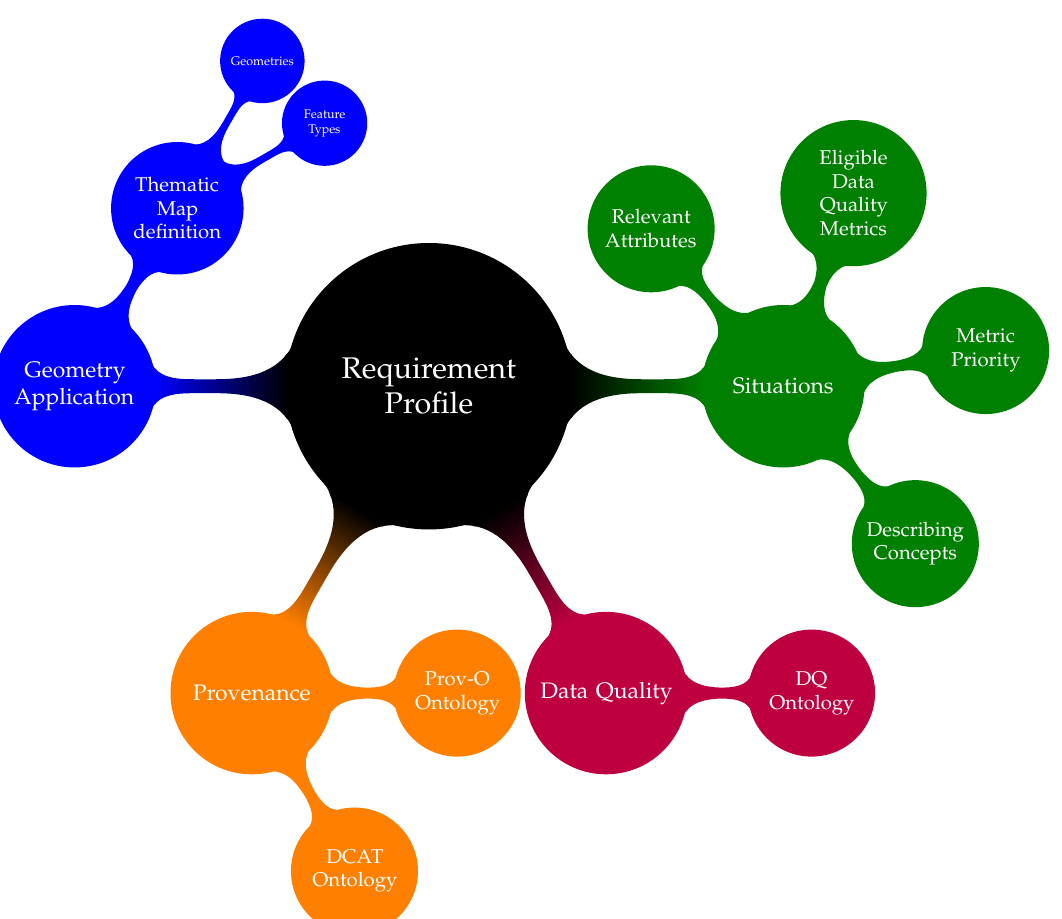
Figure 5. Complete ontology model: The ontology model contains the requirement profile as its connecting component between situations, geometries, provenance information, data quality metrics and the description of a thematic map. For each of the components, a standardized vocabulary is being used. For requirement profiles and the connection of situations to requirement profiles, the respective vocabulary is stated within this